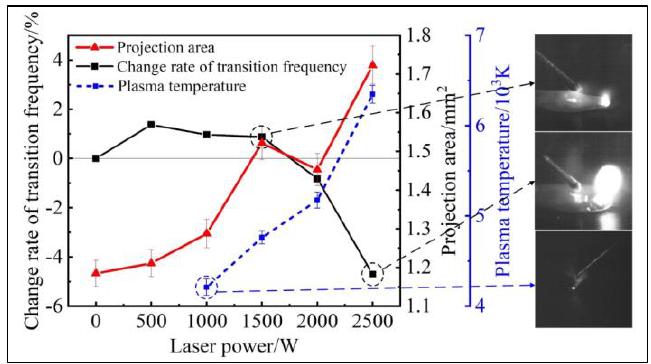
Figure 26. The effect of laser power on transfer frequency, droplet volume, and plasma temperature [111]. Reprinted with permission from [111] 2019 Elsevier. When laser acts on the combustion stage of the MIG arc, high temperature plasma attracts and compresses the MIG arc to a laser focal point. The temperature rises sharply, the arc conductivity drops, and electric field intensity drops. At the same time, the arc increases the penetration ability of the laser. The absorption of the laser energy is proportional to the density of the plasma. The high temperature and density plasma produced by individual laser welding has a great absorption effect on the energy. A large amount of low temperature and density plasma is generated during the arc combustion stage, which has a dilution effect on the plasma generated by the laser, decreasing the absorption rate of the plasma on the laser, and increasing laser penetration ability. With the increase in temperature, the laser absorptivity of the material increases, and the